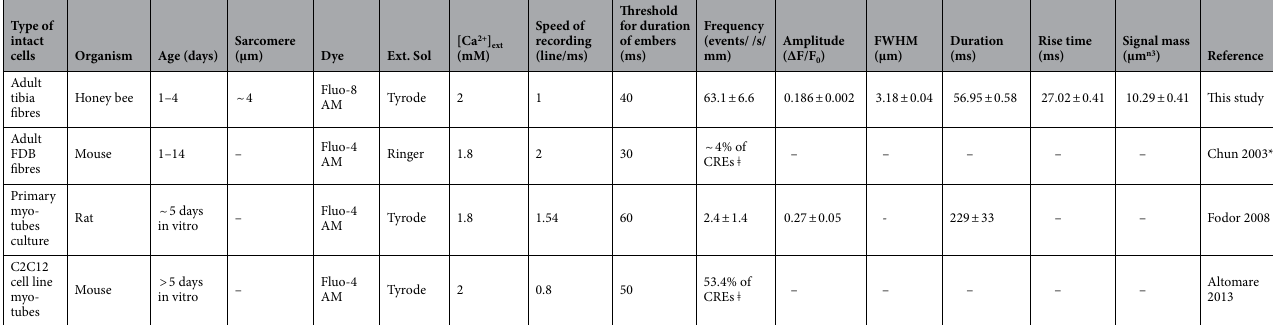
voltage-activated macroscopic transients 23 ). In intact mouse primary myotubes and in the C2C12 mouse cell line,